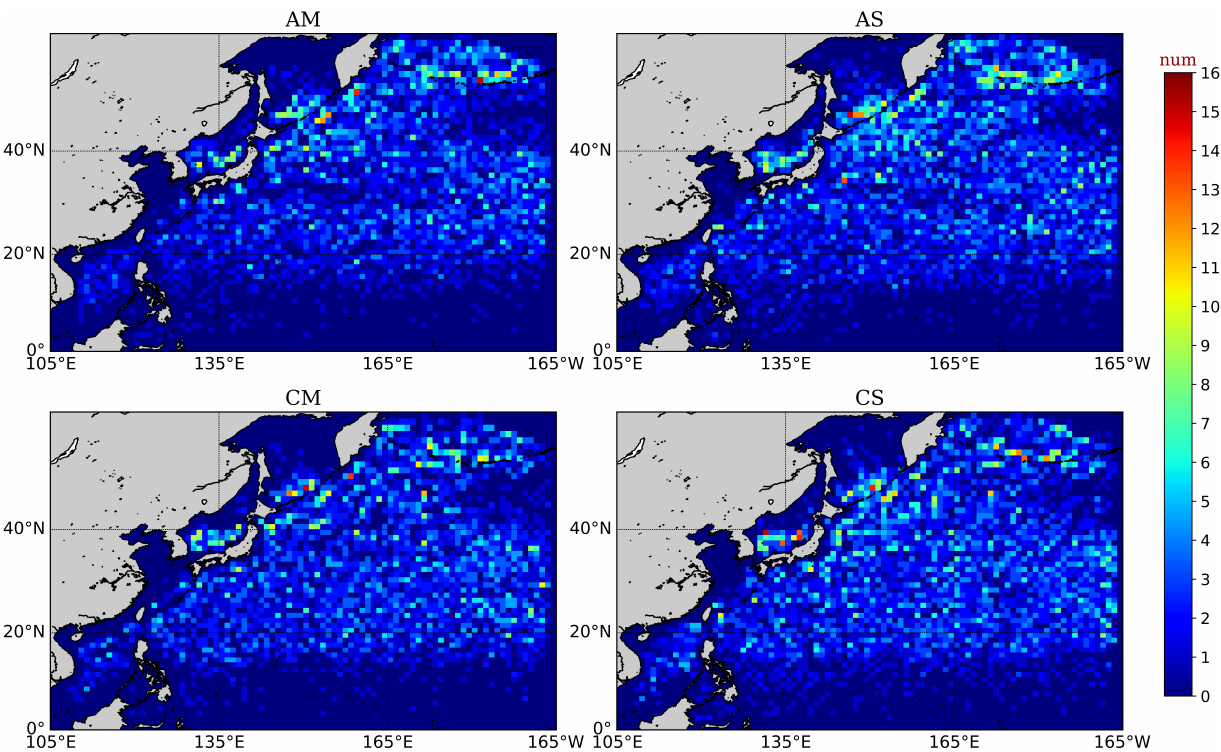
Figure 12. The census statistics of the numbers of typical eddy splitting and merging events in each 1 ◦ × 1 ◦ region over the 27-year period (January 1993–December 2019) in the Northwest Pacific (105 ◦ E–165 ◦ W, 0 ◦ N–60 ◦ N). AM, CM, AS and CS denote the typical merging events and splitting events of anticyclonic eddies and cyclonic